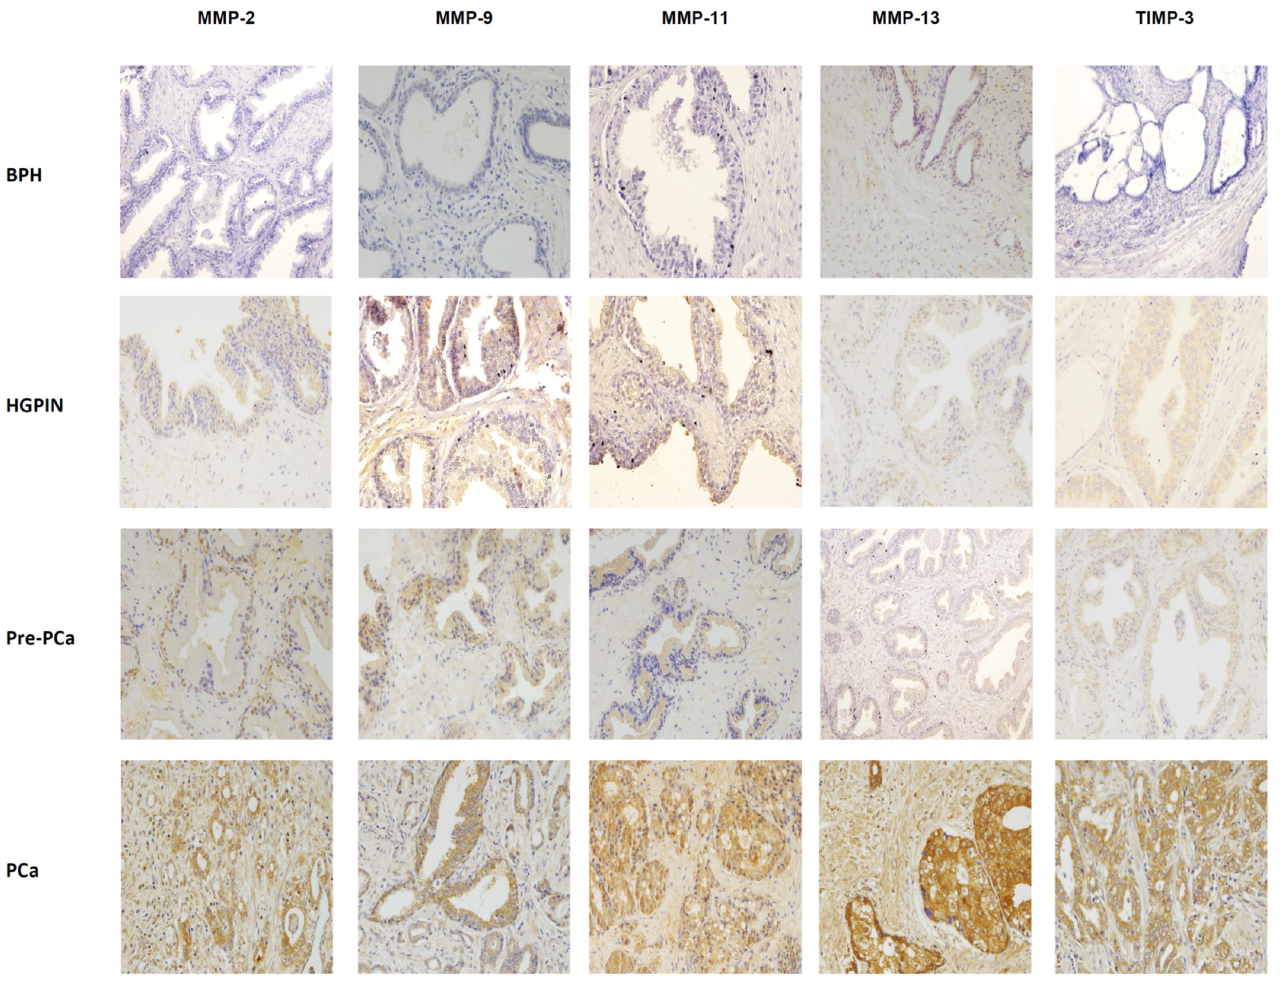
Figure 1. Immunohistochemical staining of MMP-2, -9, -11, -13, and TIMP-3 in benign (benign prostatic hyperplasia (BHP), high-grade prostatic intraepithelial neoplasia (HGPIN)) and malignant prostate tissues, before (Pre-CaP) and after prostate cancer (PCa) diagnosis. Magni fi cation: ×200.